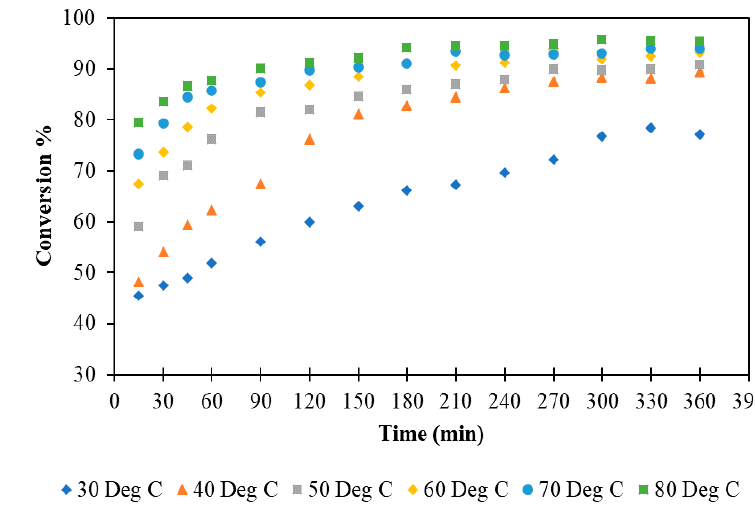
Figure 7. Effect of temperature on the conversion. Epichlorohydrin 0.1 mol, n-decane 0.03 mol, toluene 150 cm 3 , guaiacol 0.1 mol, sodium hydroxide 0.2 mol, sodium chloride 0.6 mol, tetra-n-butylammonium bromide 0.14 mol, and water 150 cm 3 . Speed of agitation 60 rpm for all three phases and reaction time 6 h.